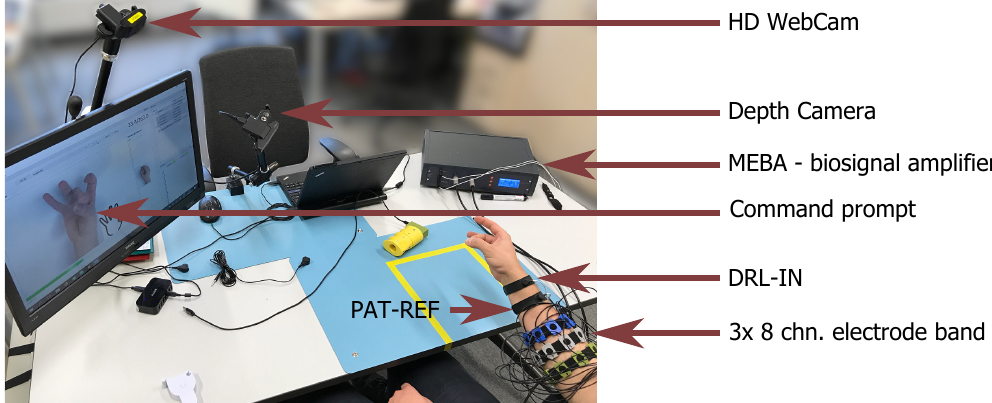
Figure 1. Setup used during the acquisition of putEMG dataset; visible placement of sEMG sensor bands and reference electrodes located near the subject’s